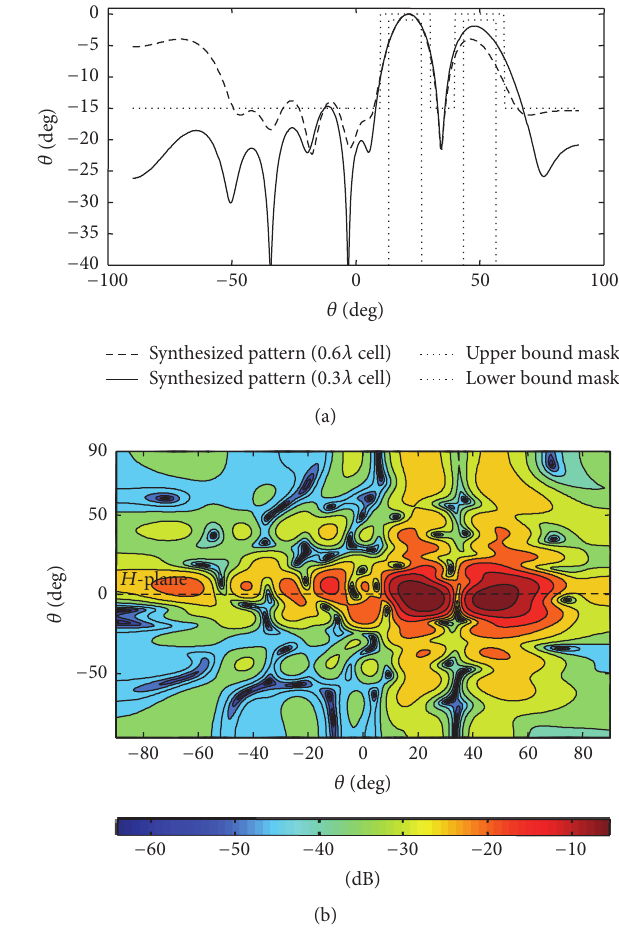
Figure 23: Design #3 : (a) synthesized 𝐻 -plane array factor; (b) synthesized 𝐸 -field contour